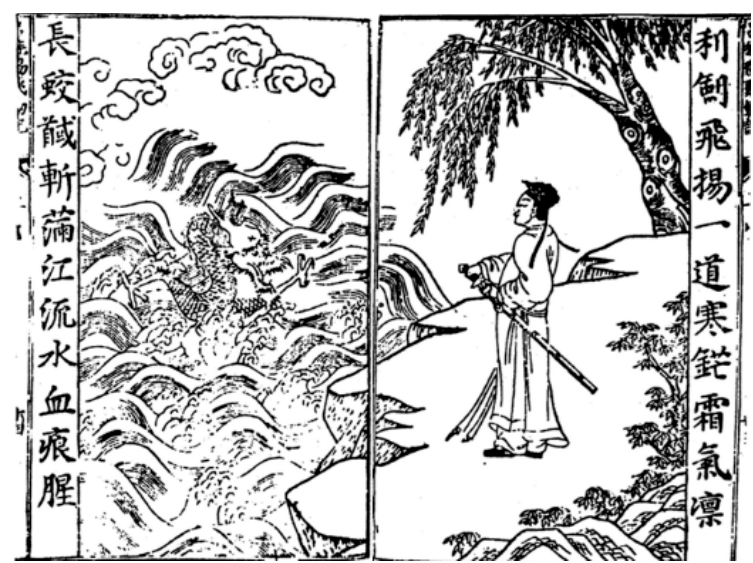
Figure 5. Lü Dongbin confronts a dragon in The Flying Sword .